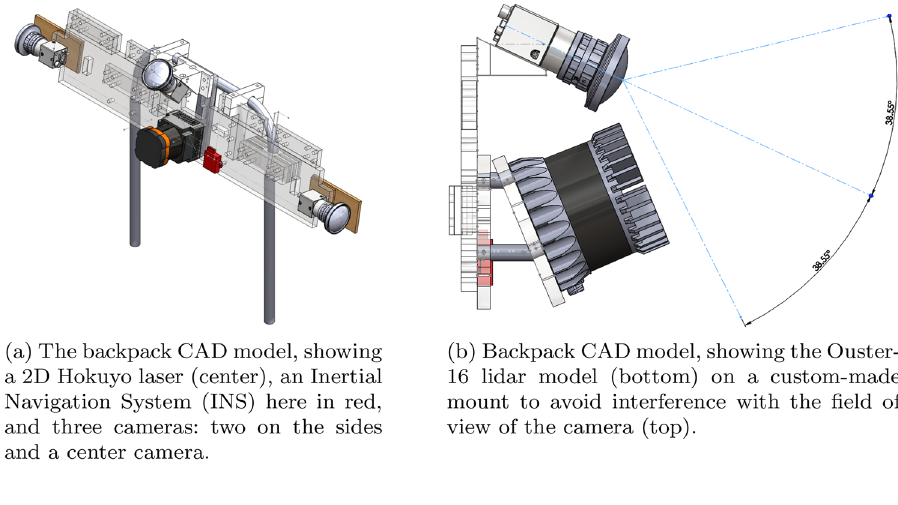
Fig. 4 Factor graph flow